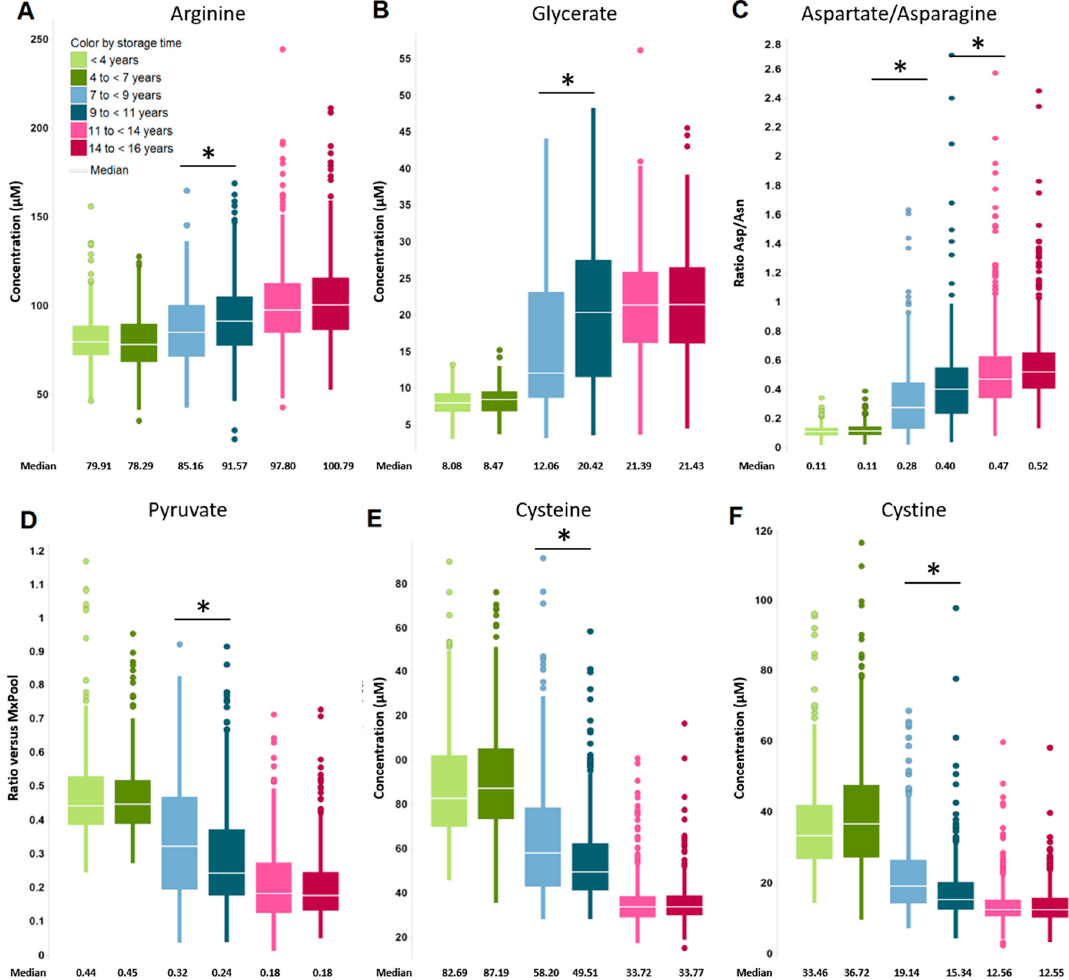
Figure 1. Metabolites or metabolite ratios that were elevated: ( A ) arginine, ( B ) glycerate, ( C ) the ratio of aspartate over asparagine or decreased ( D ) pyruvate, ( E ) cysteine, ( F ) cystine in concentration by prolonged sample storage at − 80 °C. Asterisk denotes significant changes ( p < 0.05, FDR < 0.05) within subject age groups. The legend is displayed in ( A ). Samples from one subject age group are shown in shades of the same color: 70 years of age = red; 75 years of age = blue; 80 years of age = green.